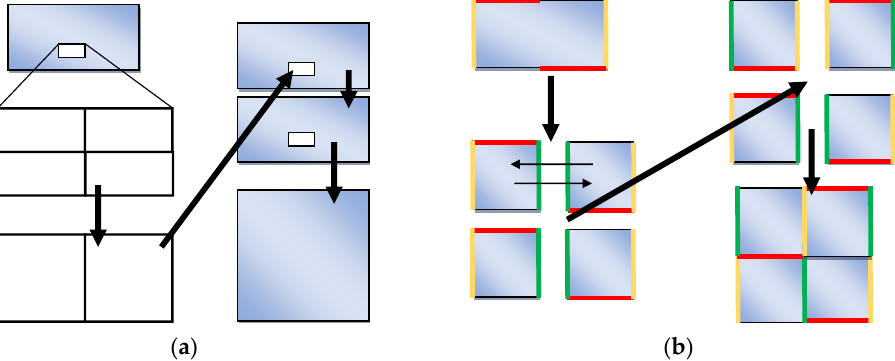
Figure 13. Doubling of space with periodic boundary conditions: ( a ) without displacement, ( b ) with displacement.